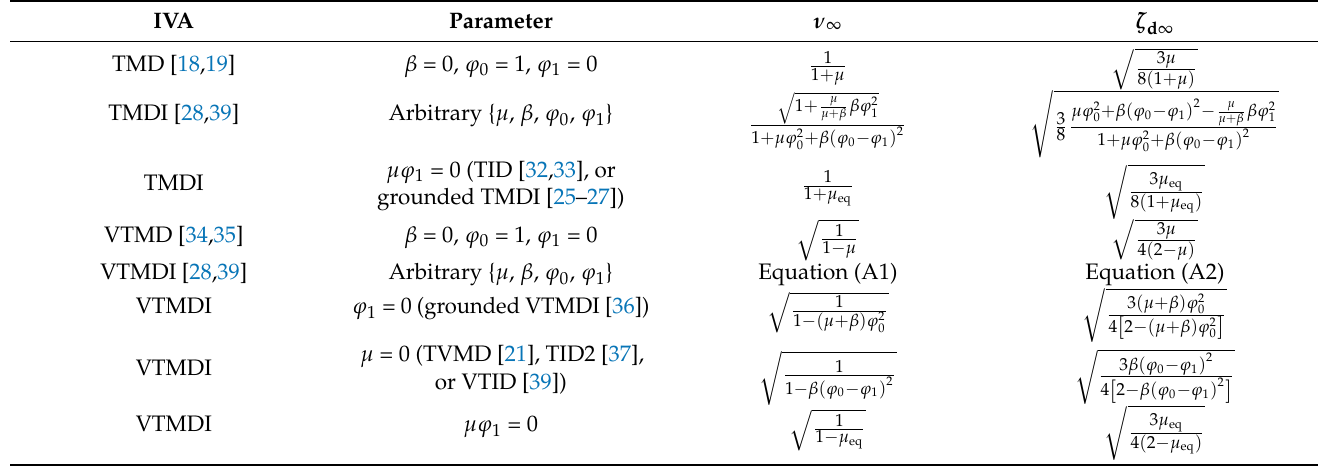
} of various IVAs obtained based d ∞